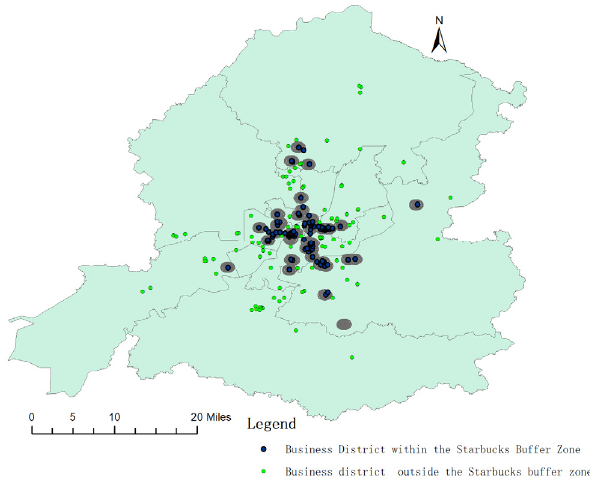
Figure 5. Coverage of Starbucks in the business circle.